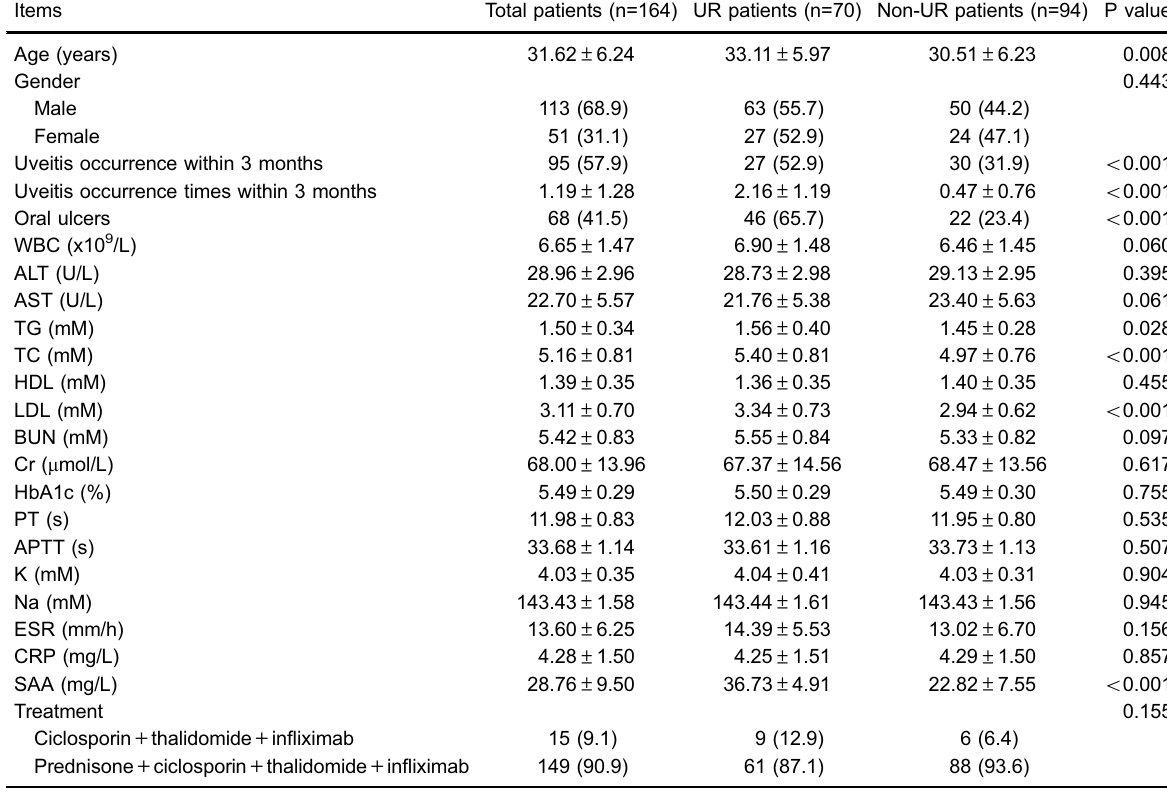
Table 1. Characteristics of Behcet ’ s disease